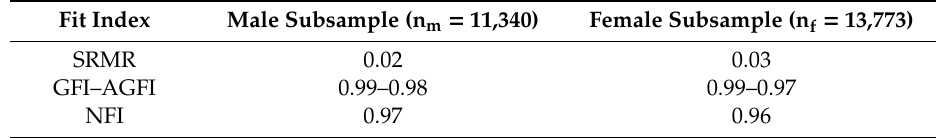
Table 4. Global fit indexes of Model 2 for two subgroups of Canadian males and